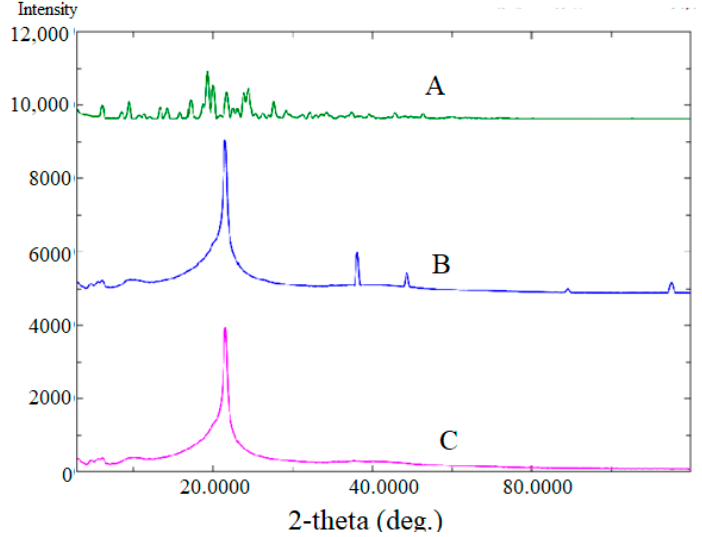
Figure 6. Comparative XRD of spectra of pure BGT (A); Span-60, Tween ® 80, and chitosan physical mixture (B); and chitosan-coated BGT-loaded NSPs (C).